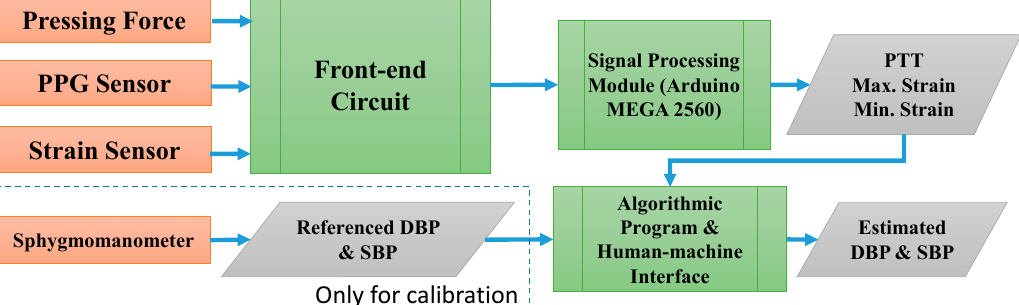
Figure 6. Signal flowchart for BP estimation.